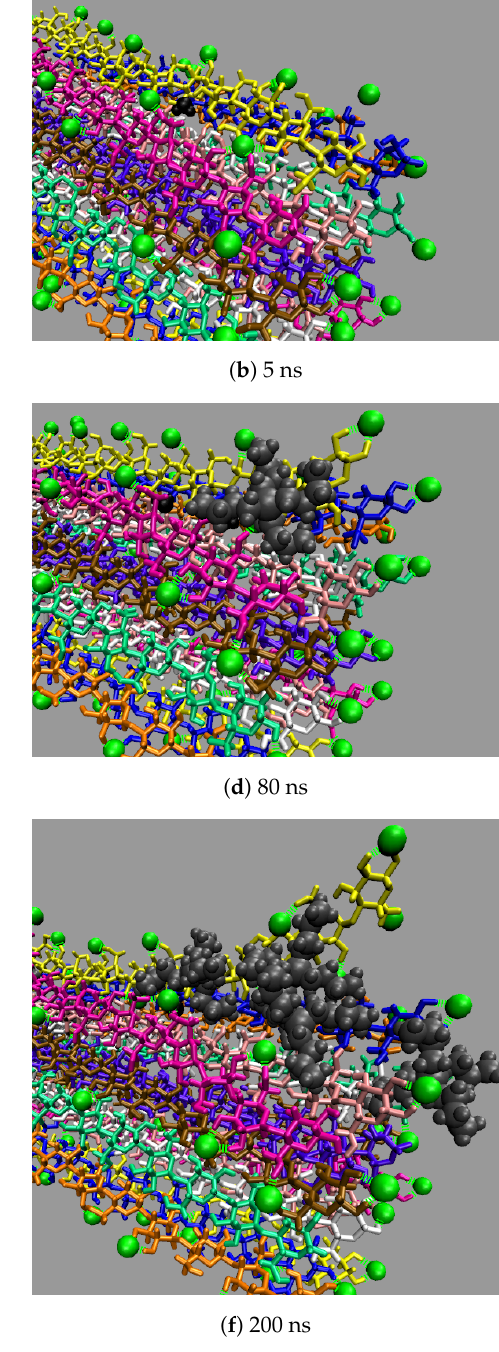
Figure 15. The cellulose dissolution process for the 63.1mol%water concentration at: ( a ) 0 ns; ( b ) 5 ns; ( c ) 40 ns; ( d ) 80 ns; ( e ) 150 ns; and ( f ) 200 ns. The green dashed lines are the Cl–cellulose hydrogen bonds. The water–cellulose hydrogen bonds are not shown in these